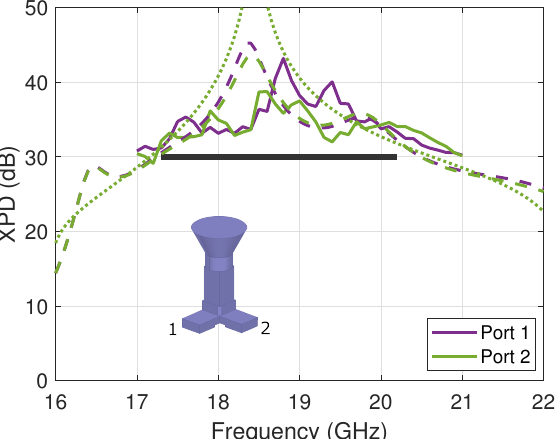
Figure 4. XPD of the compact waveguide OMT assembled with a conical horn (on-axis value), comparing measured ( solid lines ) and simulated ( dashed lines ) results. The simulated standalone OMT results are overlaid in dotted lines . The specifications are marked with a black thick line